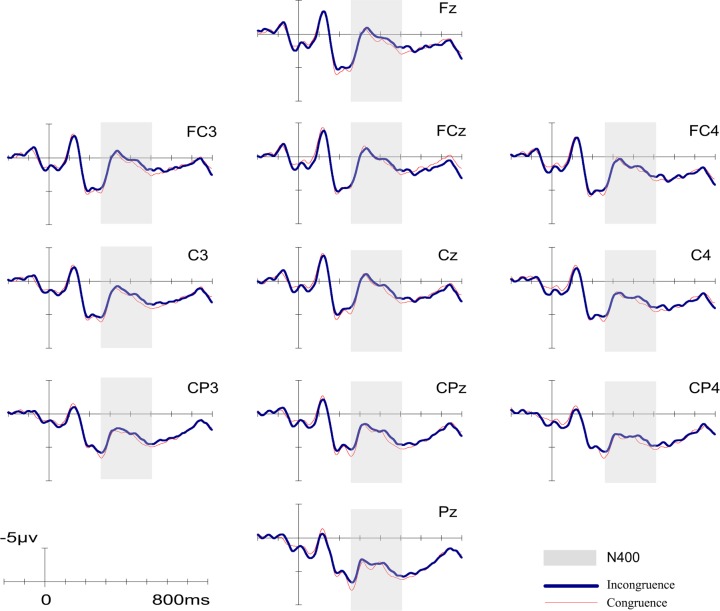
Grand-averaged ERPs in the Experiment 1 (non-music major group).N400 time windows are highlighted with gray markers. ERPs of related condition is shown as red thin lines and unrelated condition is shown as blue thick lines.